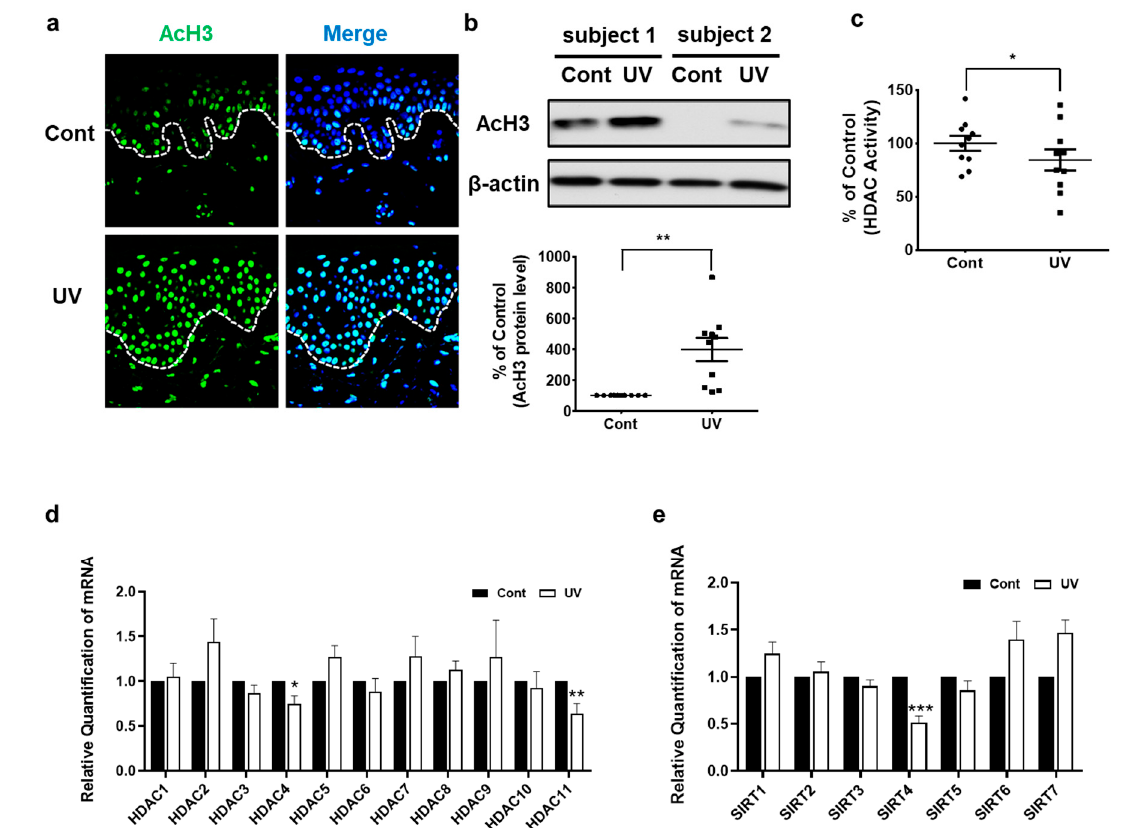
Figure 1. Acetylated histone H3 was increased, but HDAC activity and expression levels of HDAC4, HDAC11, and SIRT4 were decreased in UV-irradiated human skin in vivo. The buttock skin of young subjects was obtained by punch biopsy at 24 h after UV irradiation (two minimal erythema doses (MEDs)). Immunofluorescence analysis of AcH3 and DAPI staining of paraffin-embedded sections ( n = 6). Original magnification: ×200 ( a ). Western blot analysis of AcH3. The bands are representative of the results obtained for 10 subjects. The bar graph shows densitometric quantification of AcH3 levels. ( n = 10) ( b ). Total HDAC activity was measured using an HDAC assay kit ( n = 10) ( c ). Expression levels of HDAC and SIRT mRNAs following UV irradiation were compared with those in non-irradiated control skin by qPCR ( n = 10) ( d , e ). Data were normalized to the control. Data are presented as means ± SEM. Statistical significances were determined using a two-tailed paired t -test. * p < 0.05, ** p < 0.01, *** p < 0.001 vs. non-irradiated skin (Cont). Cont: control.